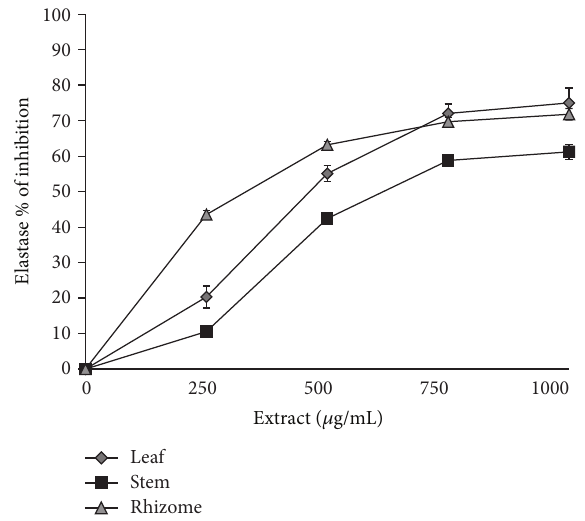
Figure 3: Elastase % of inhibition from extracts of Anemopsis